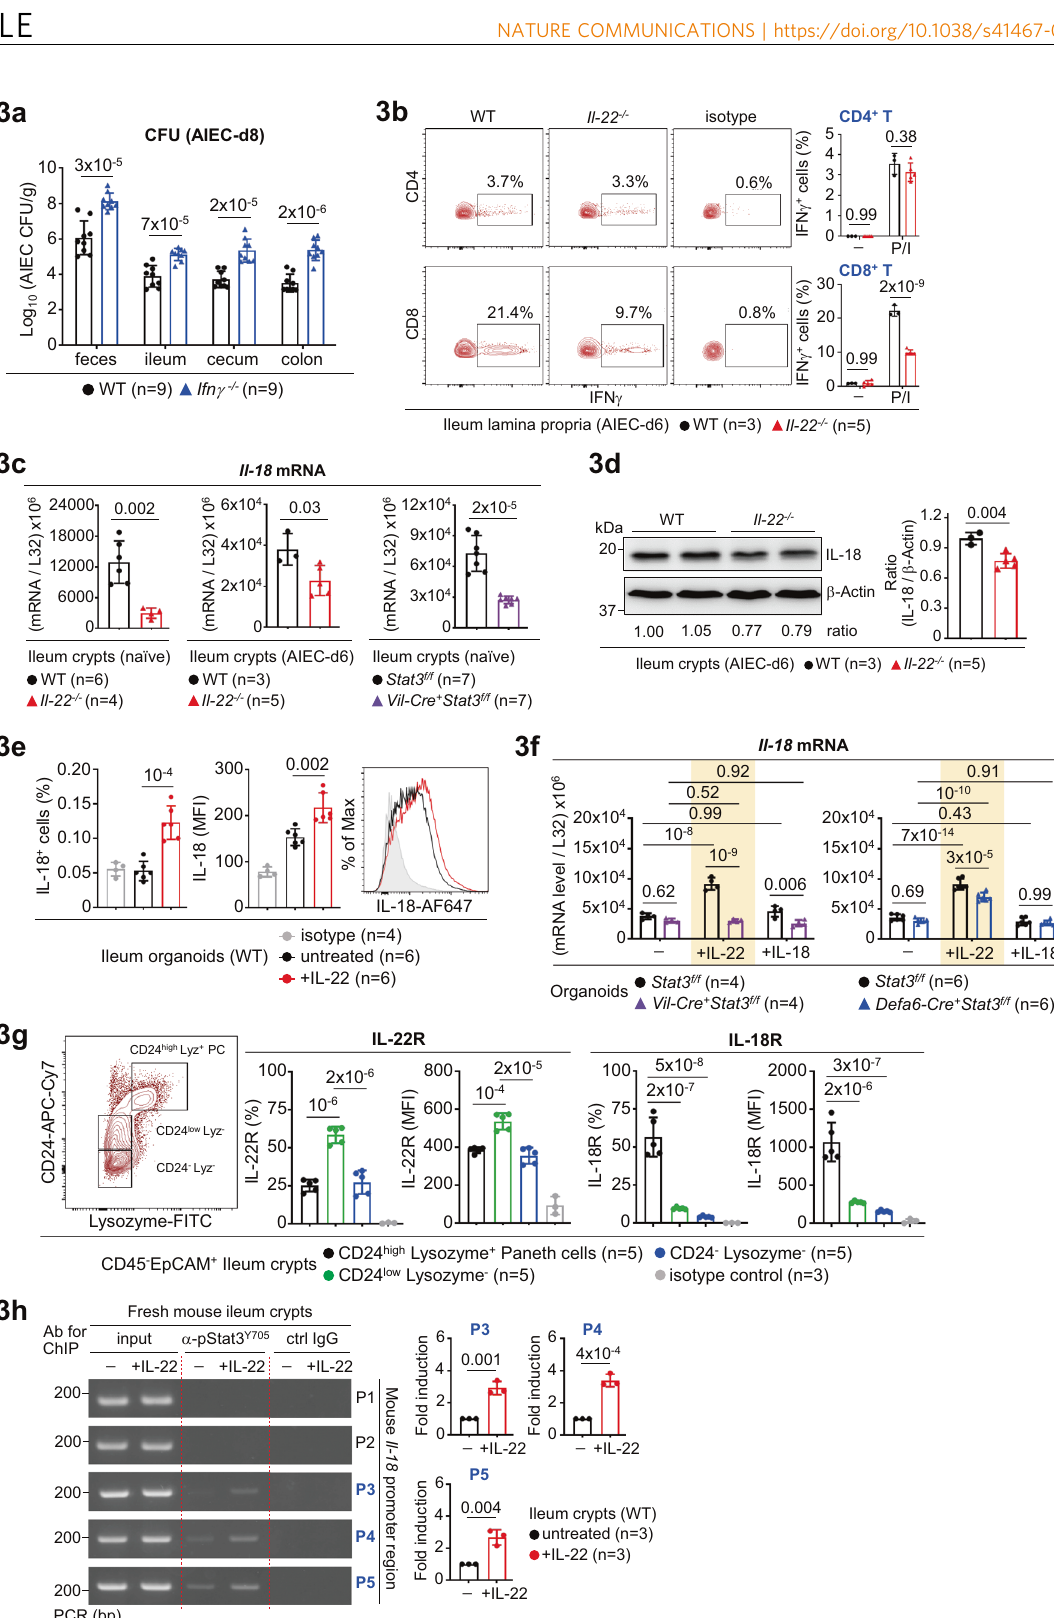
IL-18 contributes to Paneth cell homeostasis. As noted, loss of Il- 18 in mice led to reduced mRNA levels of AMP, IFN γ , Dll1/4 (Supplementary Fig. 4f-g) 27 , a key transcription factor important